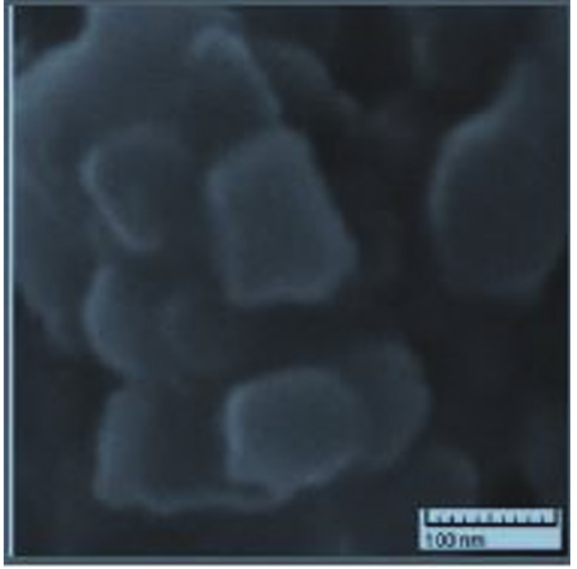
Figure 10: Sem Microstructures of Titanium Carbide Synthesized at 1300 ° C for 1